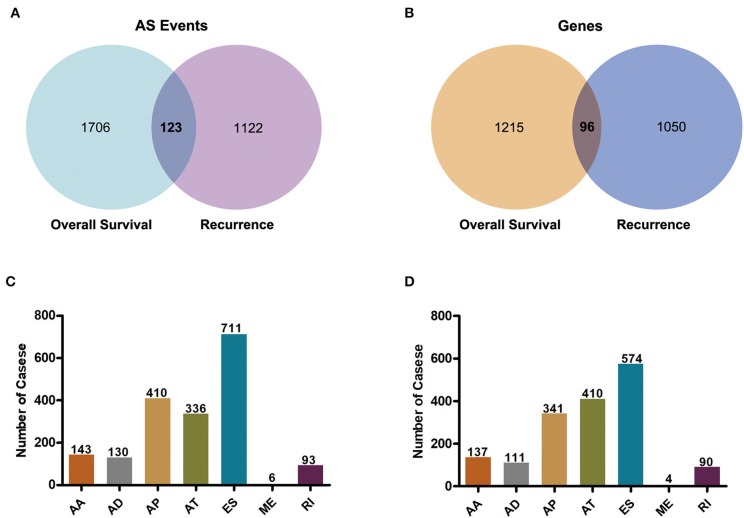
Overview of prognosis-related alternative splicing events in GBM. (A) Venn diagram of AS events of genes significantly related to overall survival and those related to recurrence after radio- and chemo-therapy. (B) Venn diagram of gene intersections in AS events of genes significantly related to overall survival and those related to recurrence after radio- and chemo-therapy. (C) Histogram of the 7 types of AS events that were markedly correlated with overall survival in the gene AS events. (D) Histogram of the 7 types of AS events that were remarkably correlated with recurrence after radio- and chemo-therapy for gene AS events.